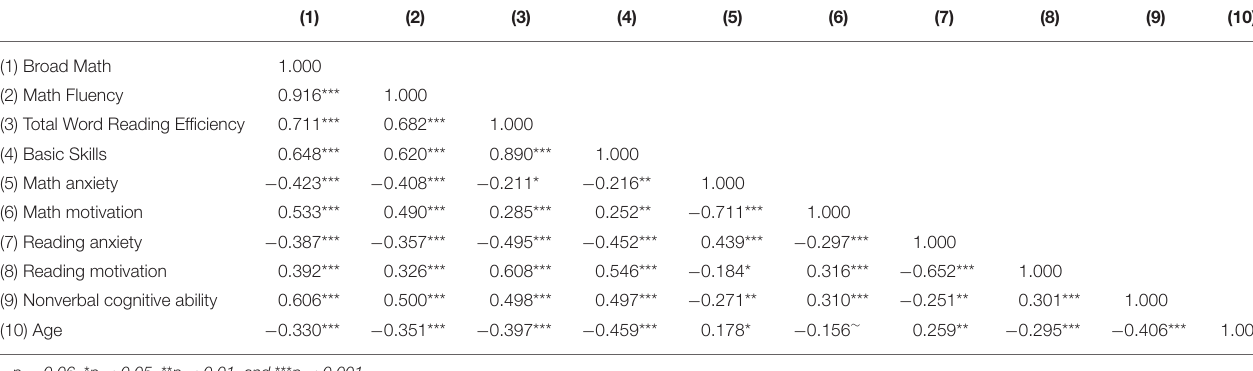
TABLE 3 | Bivariate correlations among competence (1–4), socio-emotional characteristics (5–8), KBIT scores, and age ( n = 146).